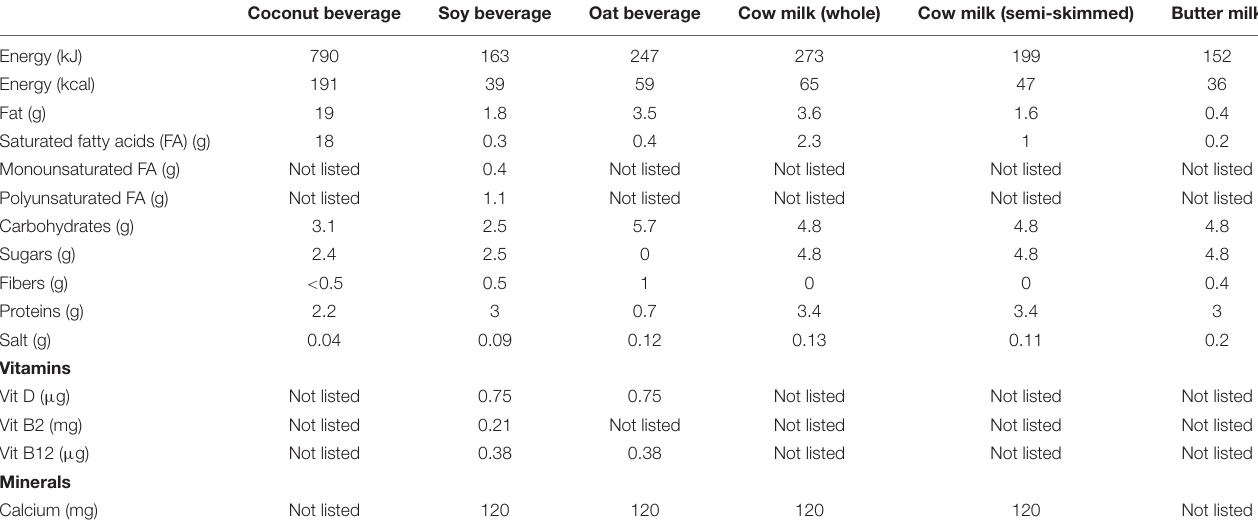
TABLE 1 | Nutritional composition of food matrices used in this study. Coconut beverage Soy beverage Oat beverage Cow milk (whole) Cow milk